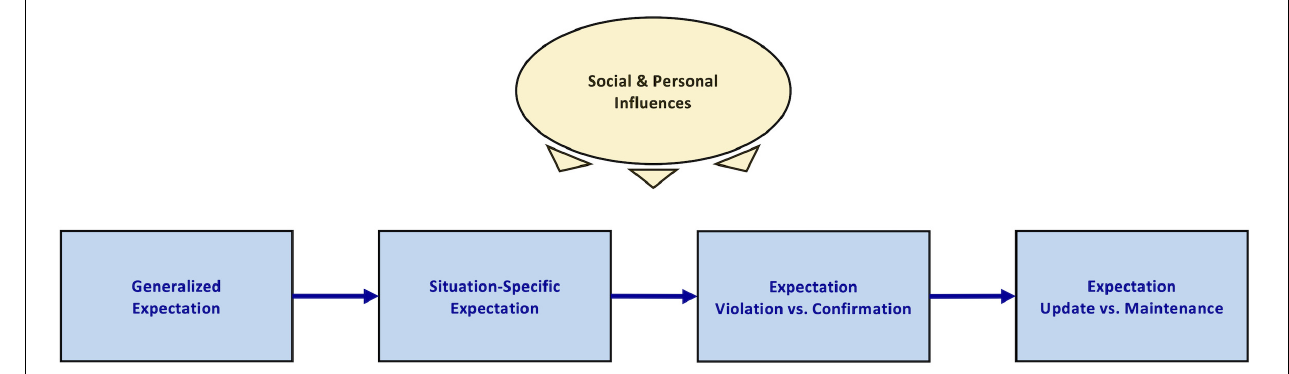
FIGURE 1 | Synopsis level (Level 0) of the ViolEx 2.0 model. Overall, the model aims to inform and facilitate research on the predictors and mechanisms of expectation update and maintenance, particularly in the context of expectation violations. Generalized expectations are expectations that individuals have about groups of similar situations and their potential outcomes. Given a particular situation, generalized expectations inform more concrete situation-specific expectations. Depending on whether the outcome of a situation is consistent with an expectation or not, this expectation is confirmed or violated, respectively. Following expectation violation (or confirmation), individuals may either update their expectation to increase consistency with the situational outcome or maintain their expectation. Identical expectations, situations, and situational outcomes may still result in differences in expectation updating or maintenance across occasions and across individuals, given moderating social and personal